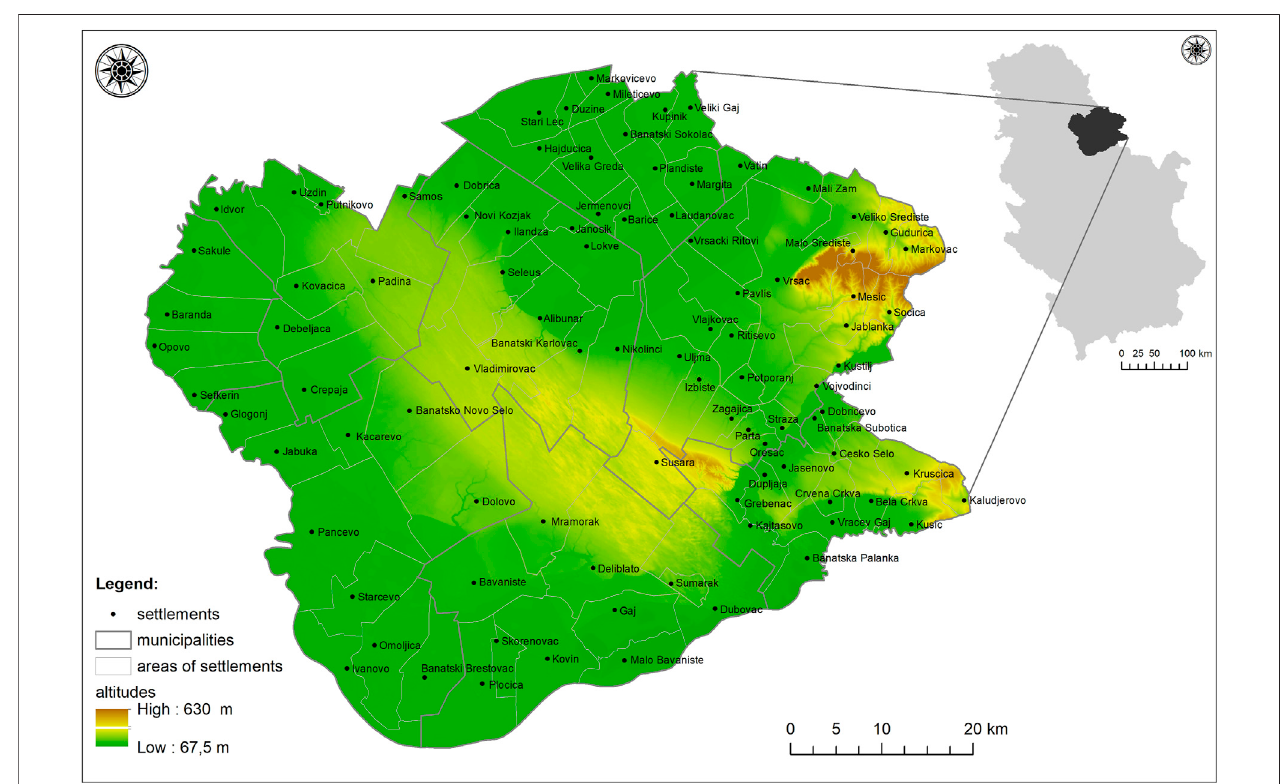
FIGURE 1 | The geographical position of the research